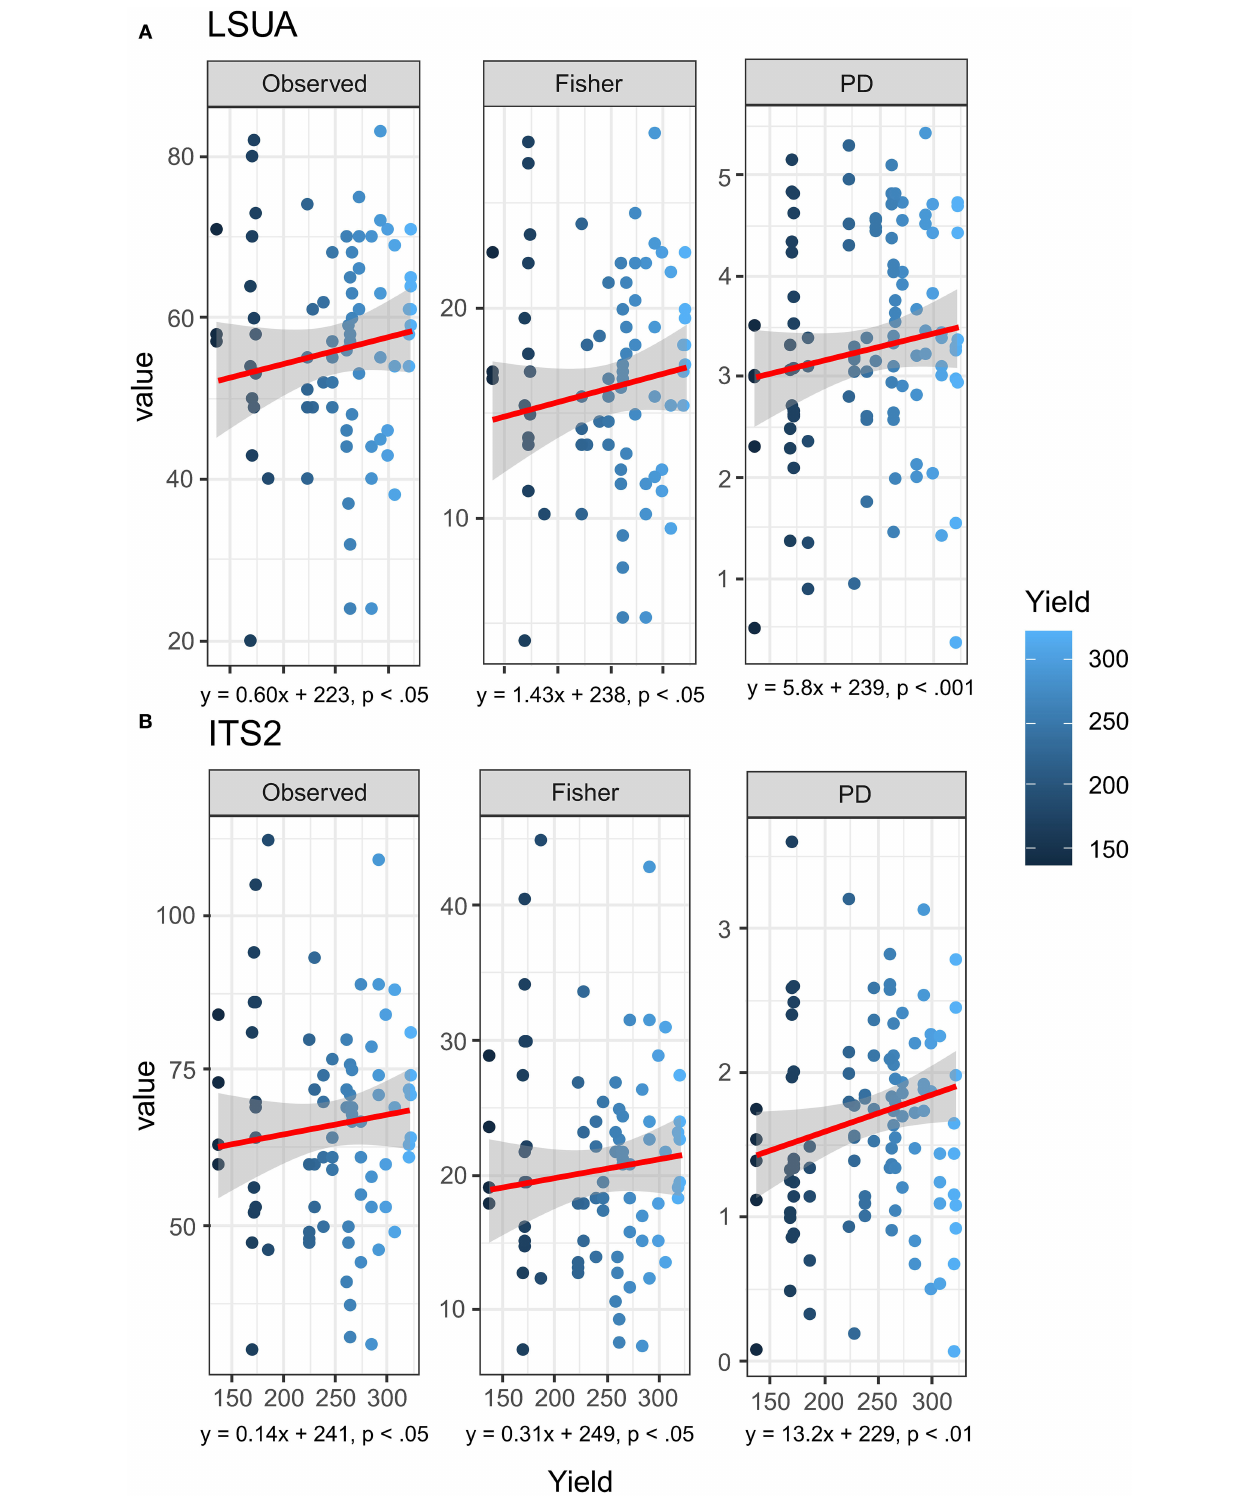
FIGURE 8 | Kendall-Theil Sen Siegel non-parametric linear regressions on rarefied ( n = 500 OTU counts) for (A) LSUA and (B) ITS2 primers using multiple diversity and evenness indices: OTU richness (Observed), Fisher’s alpha (Fisher) diversity, and Faith’s Phylogenetic Diversity (PD) index.